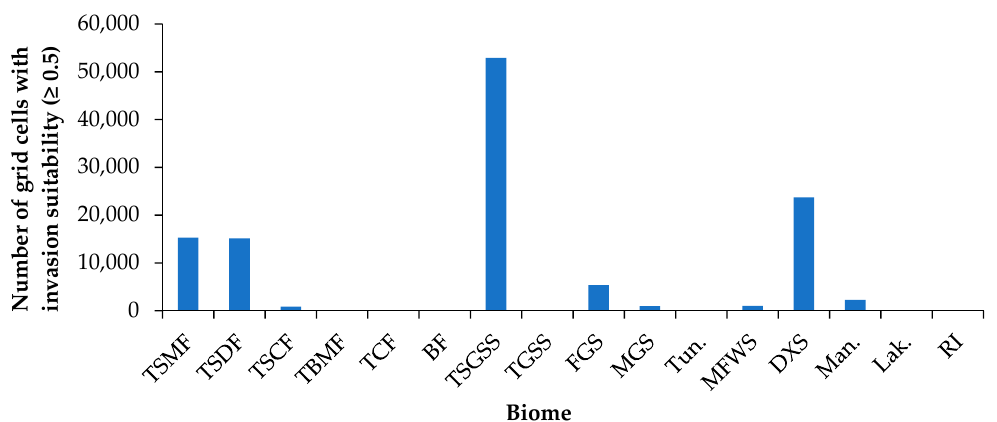
Figure 4. Invasion risk to global biomes with high habitat suitability ( ≥ 0.5) for the invasion of P. juliflora . Abbreviations: TSMF = Tropical and Subtropical Moist Broadleaf Forests; TSDF = Tropical and Subtropical Dry Broadleaf Forests; TSCF = Tropical and Subtropical Coniferous Forests; TBMF = Temperate Broadleaf and Mixed Forests; TCF = Temperate Conifer Forests; BF = Boreal Forests/Taiga; TSGSS = Tropical and subtropical grasslands, savannahs, and shrublands; TGSS = Temperate Grasslands, Savannahs, and Shrublands; FGS = Flooded Grasslands and Savannahs; MGS = Montane Grasslands and Shrublands; Tun. = Tundra; MFWS = Mediterranean Forests, Woodlands, and Scrub; DXS = Deserts and Xeric Shrublands; Man. = Mangroves; Lak. = Lakes; RI = Rock and Ice.